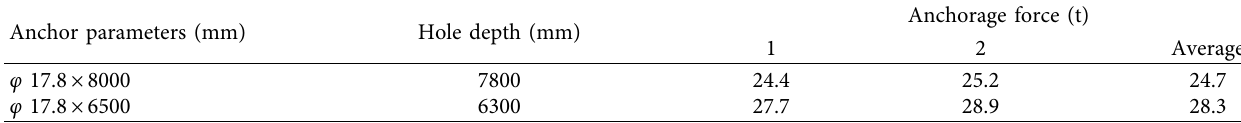
Table 2: Anchorage force test